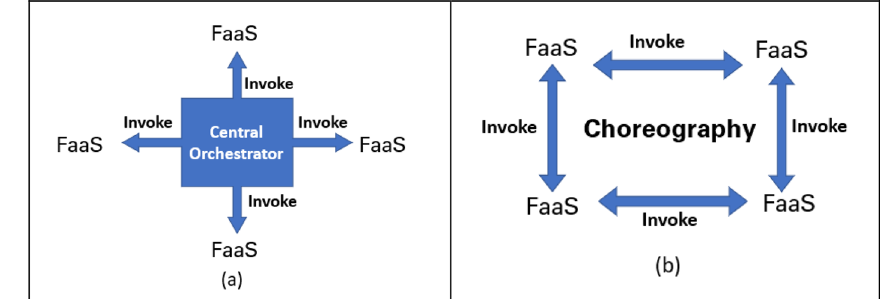
Fig. 1 Function Composition Approaches ( a ) Orchestration ( b )